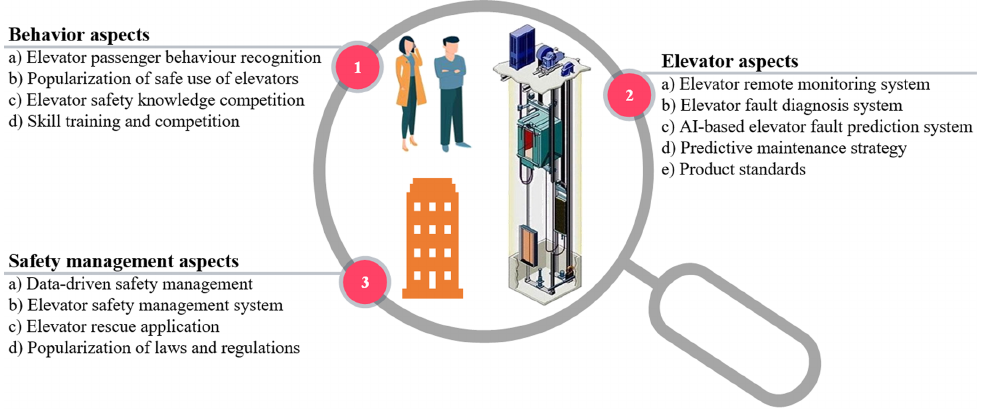
Fig. 7 Some countermeasures and suggestions for reducing elevator